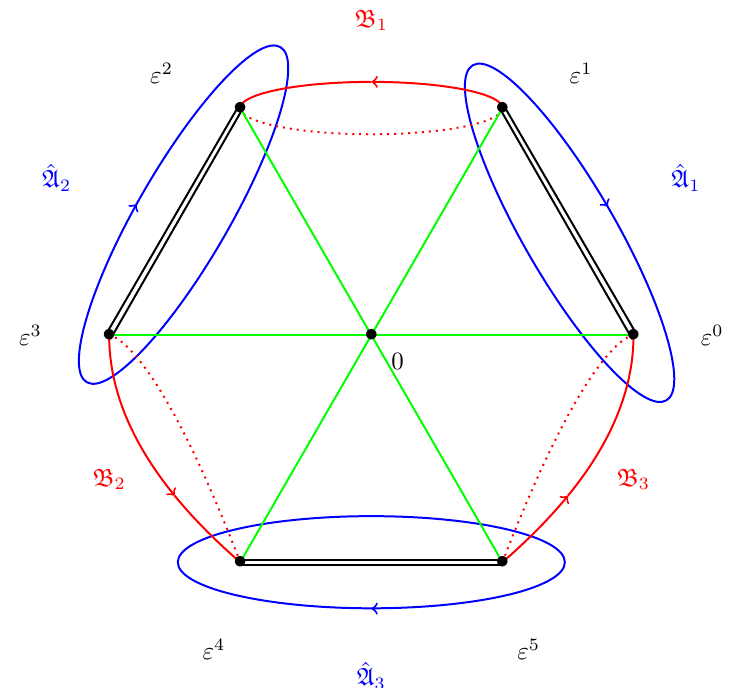
y 2 = x 2 N 1 for the special 2 N -symmetric curve −